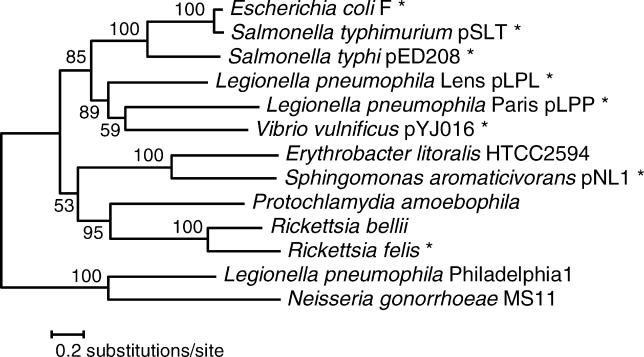
Phylogenetic Tree of the Proteins Encoded in the F-Like tra Gene ClustersThe tree was built using a maximum likelihood method with JTT substitution model and midpoint rooting based on the concatenated sequence alignment of TraDF and TraGF. Plasmid encoded sequences are indicated by asterisks. Other sequences are encoded in the chromosomes.